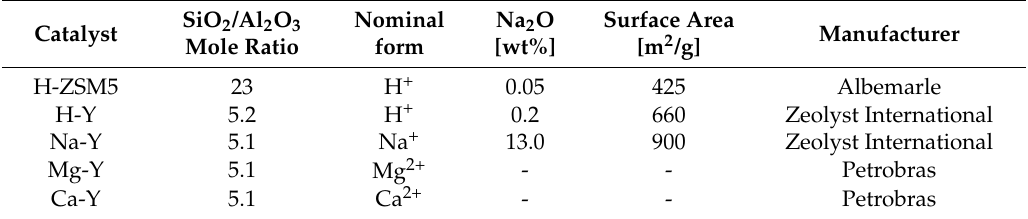
Table 3. Properties of zeolite